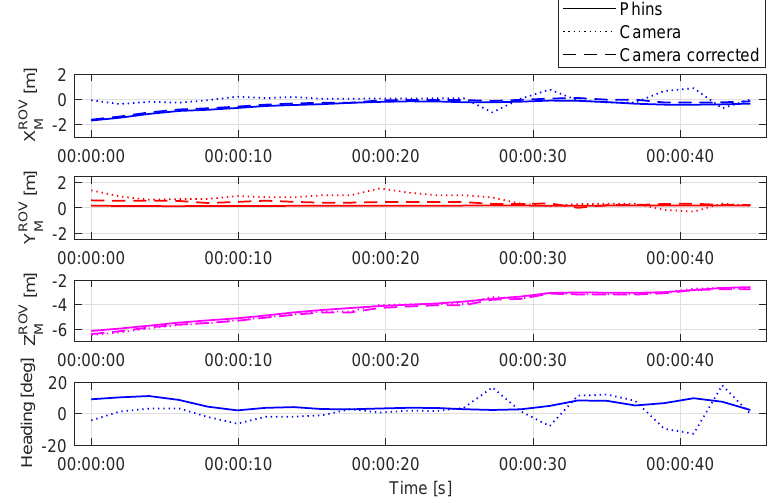
Figure 11. Position estimation of the camera in marker coordinate frame during the dynamic